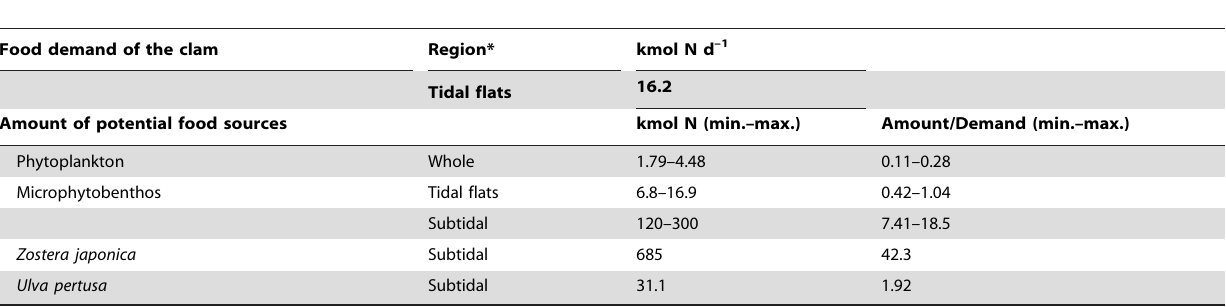
Table 2. Food demand of the clam ( Ruditapes philippinarumm ) and total amount of potential food sources during the productive season.